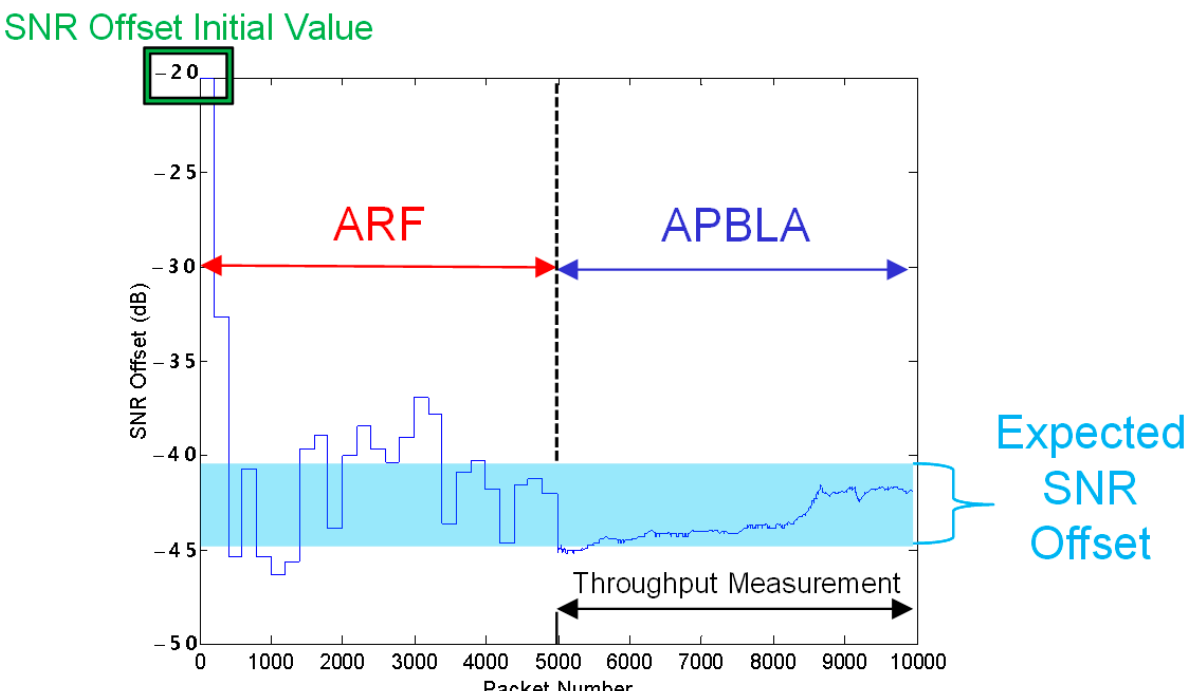
Figure 24. SNR offset variation with time for ARF + APBLA (test T5). Measurement results are analyzed by exploiting the channel information from the wireless tests. In Figure 25, the channel quality (left) and MCS variations (right) with time are plotted in the T1 test environment (ARF only). The MCS selected by ARF goes up and down repeatedly and quickly and hence it is inferred that the width of the channel variation will be large, which may also be identified in the left half of Figure 25 that shows the channel quality variation over time.